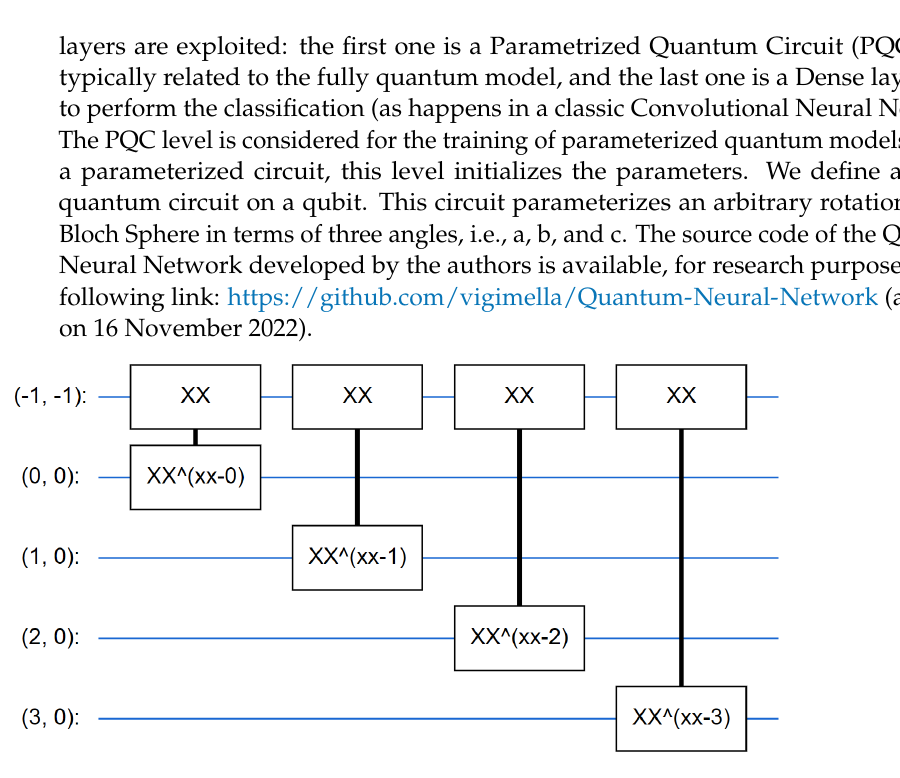
Figure 5. Circuit layer example, where the quantum circuit is composed of a sequence of parameter-dependent unitary transformations aimed to work as an input quantum state. The input quantum state is composed of an n-bit computational basis state that corresponds to a sample